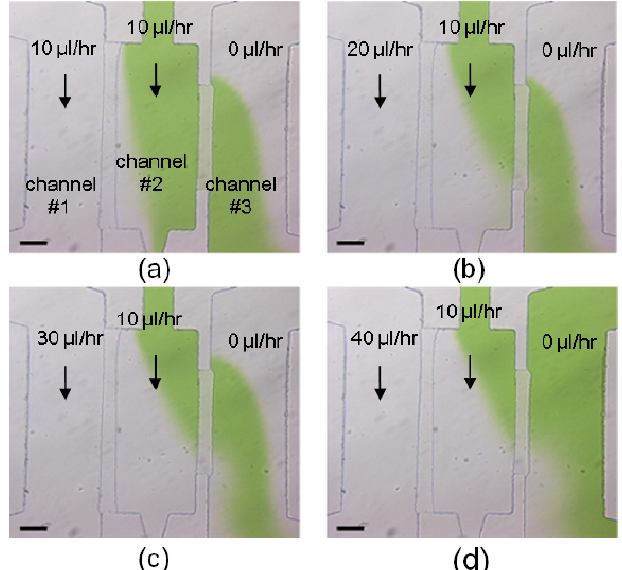
Figure 3. To test microfluidics for cell docking, the central flow rate is maintained at 10 µL/h, and the flow rates in a left channel were injected at: ( a ) 10 µL/h, ( b ) 20 µL/h, ( c ) 30 µL/h, ( d ) 40 µL/h. As the flow rate in a left channel increased, the central dye flow was visibly pushed to the right channel. Scale bar : 100 μ m.